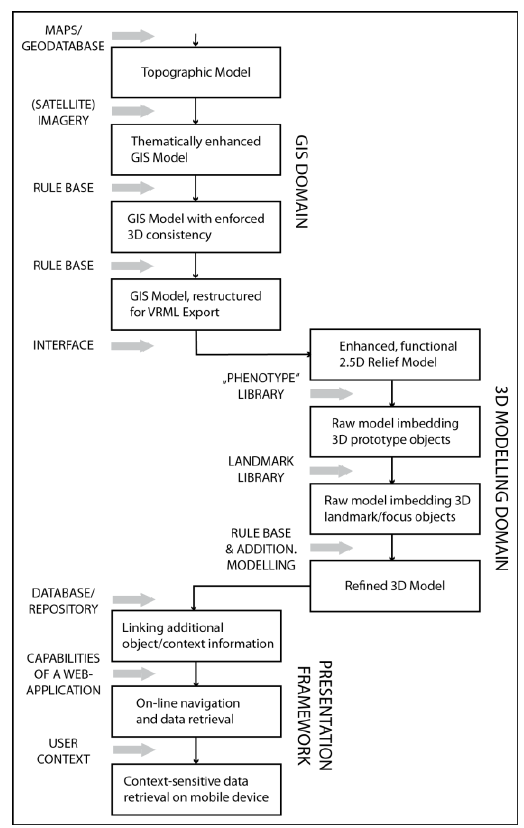
Figure 6: Simplified Workflow from GIS to a 3D presentation